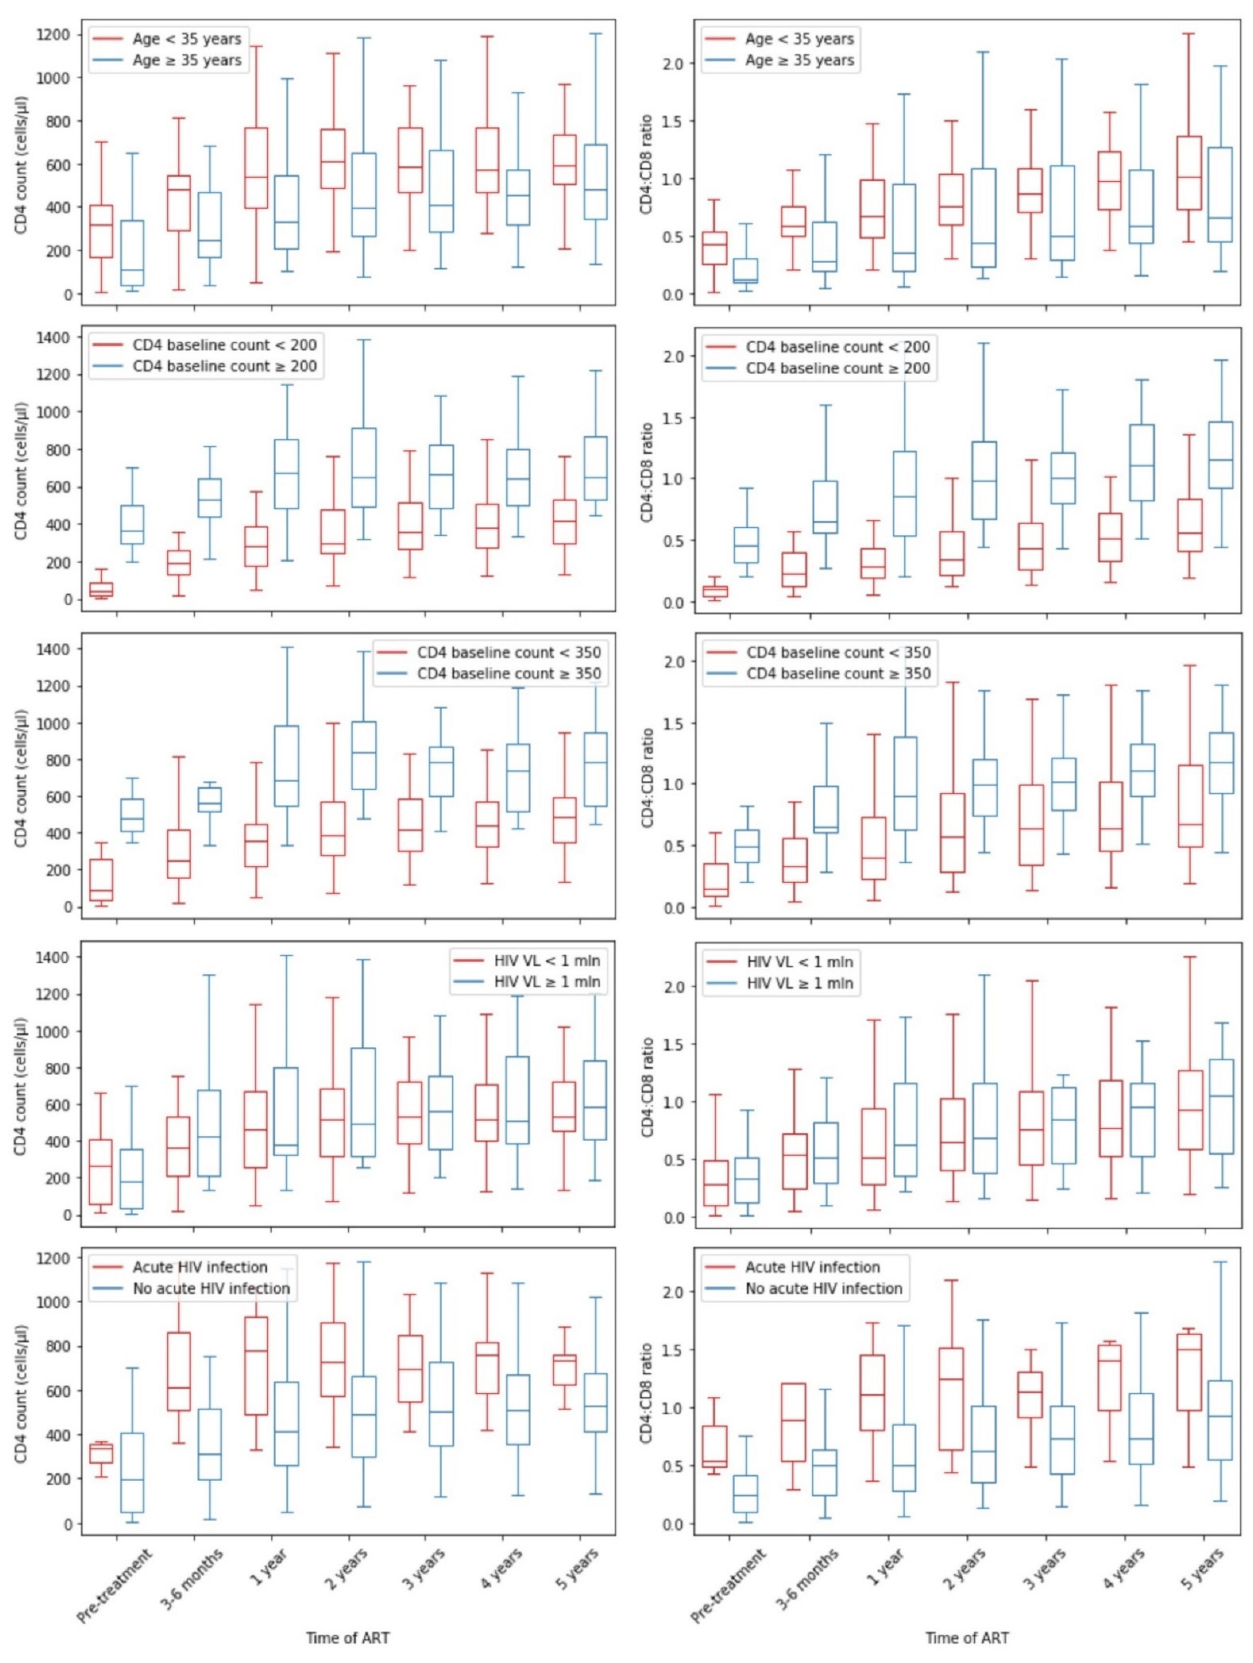
Figure 3. CD4 and CD4:CD8 recovery during 5 years of ART depending on clinical